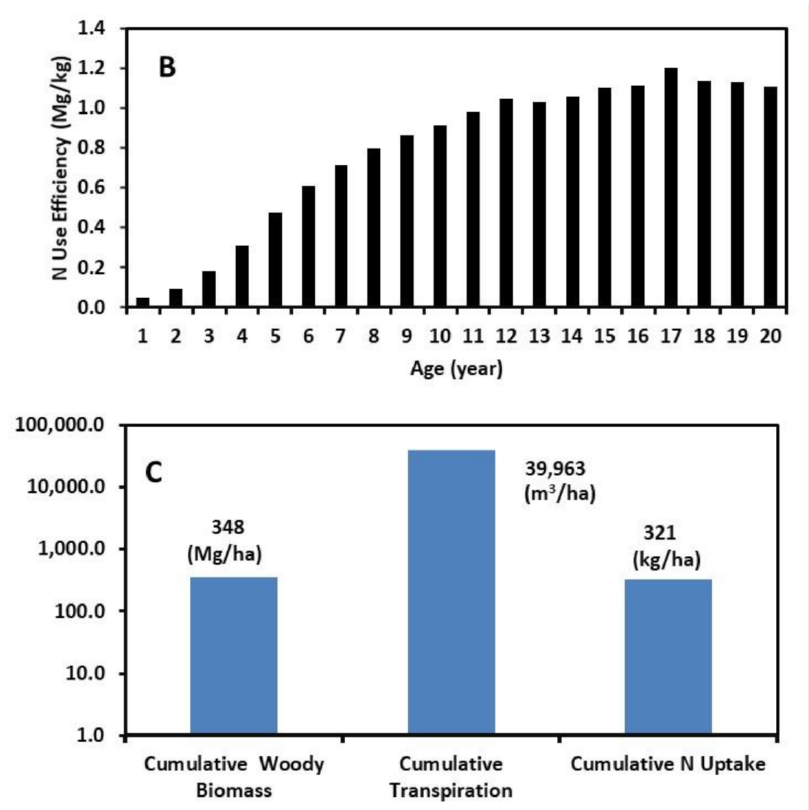
Figure 8. ANPP as a function of N uptake ( A ); NUE as a function of eucalyptus age ( B ); and comparison of cumulative woody biomass, water use (transpiration), and N uptake for a simulation period of 17 years during the eucalyptus growing stage ( C